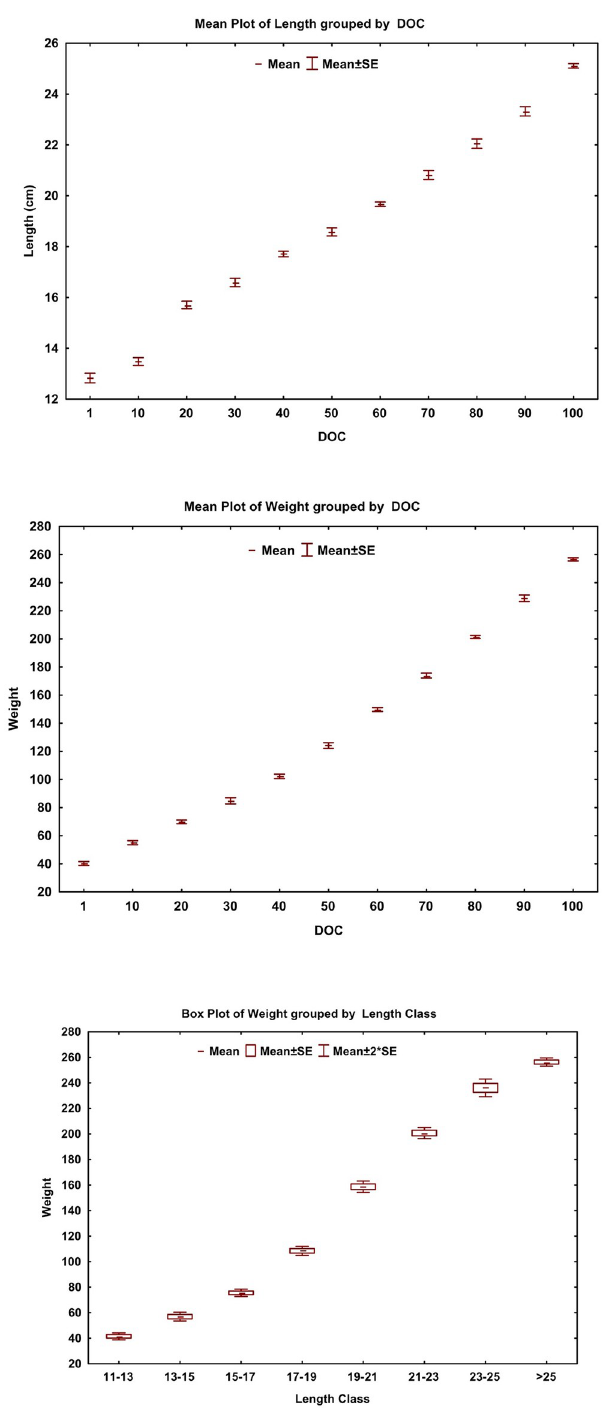
Fig 3. Length and weight progession of Silver pompano and mean weight across different length class during 100-days of grow-out culture.